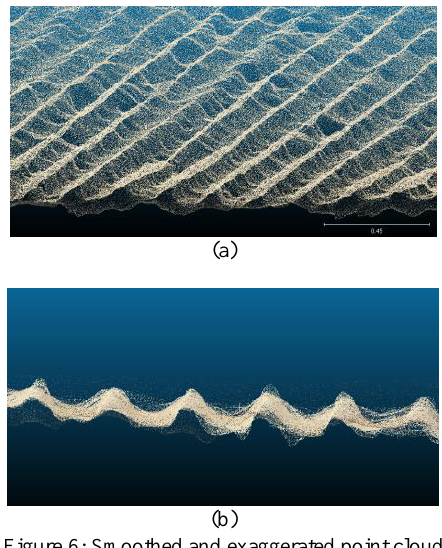
Figure 4: Mesh generation and smoothing; (a) Noisy mesh, (b) Smoothed mesh